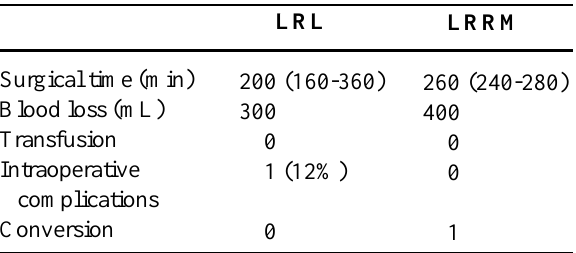
Table 2 – Intraoperative data from LRL and LRRM.